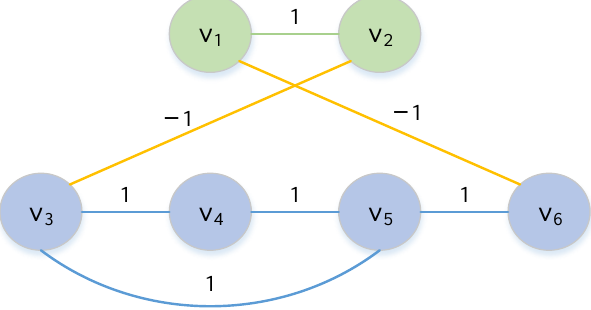
Figure 1. Communication topology.